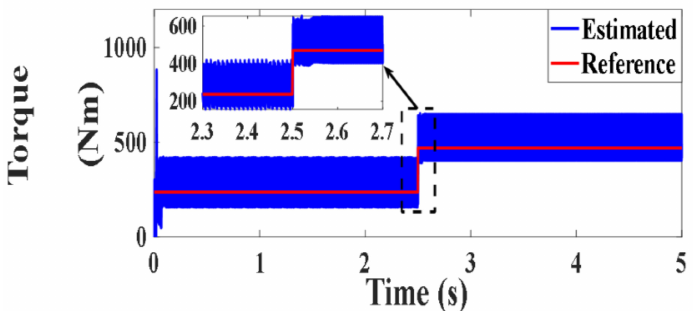
Figure 47. Torque under MPDTC (Nm).